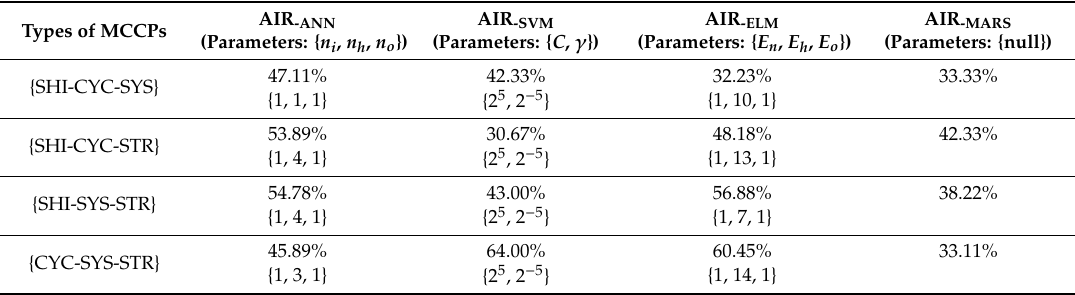
Table 4. Results of MCCP recognition for three process outputs (first scheme: without the use of EPC). Types of MCCPs